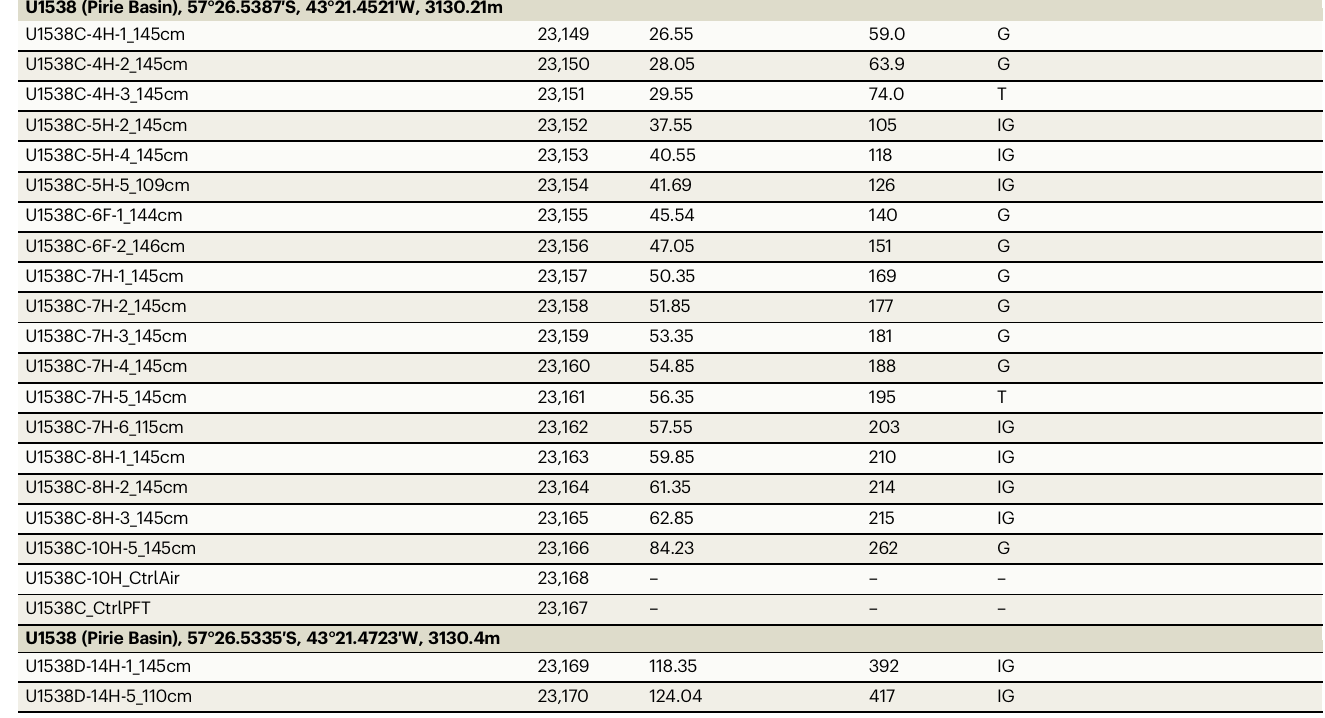
Listed are all sed aDNAsamplesas well as controlscollected alongsidesedimentsamples (AirControls andPFMD (PFT)controls). IODPExpedition382 Sites(incl. section names), as well as their latitude,longitudeandwaterdepth(m)areprovided.TopdepthCSF-Acorrespondstometresbelowsea fl oor(mbsf).Ageswereassignedbasedonref.45(Methodssection)andglacial/interglacial assignmentswere basedonrefs. 26,